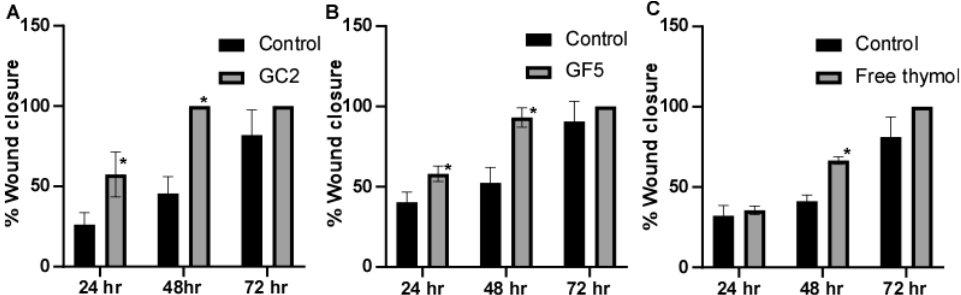
Figure 8. Wound-closure effect of ( A ) GC2, ( B ) GF5, and ( C ) free thymol hydrogel on the wound- healing process compared with the untreated group. Mean values of three independently produced experiments ± S.E. * indicates significant difference at p < 0.05, compared to control group.